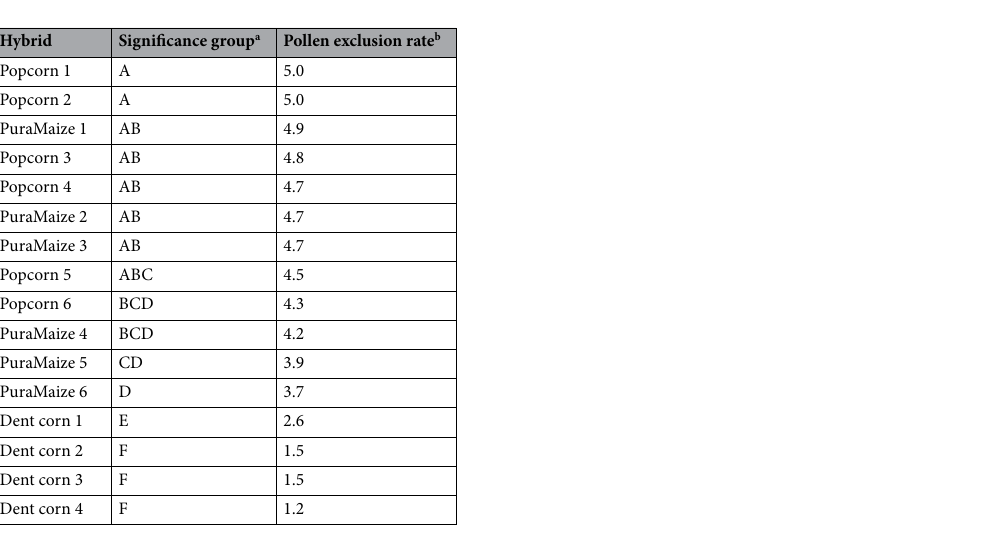
Table 3. Pollen exclusion ratings of 6 popcorn, 6 PuraMaize and 4 dent corn hybrids. a Hybrids connected by the same letter are not significantly different from each other. b Mean rating, 5 = 0–20% blue kernels, 1 = 80–100% blue